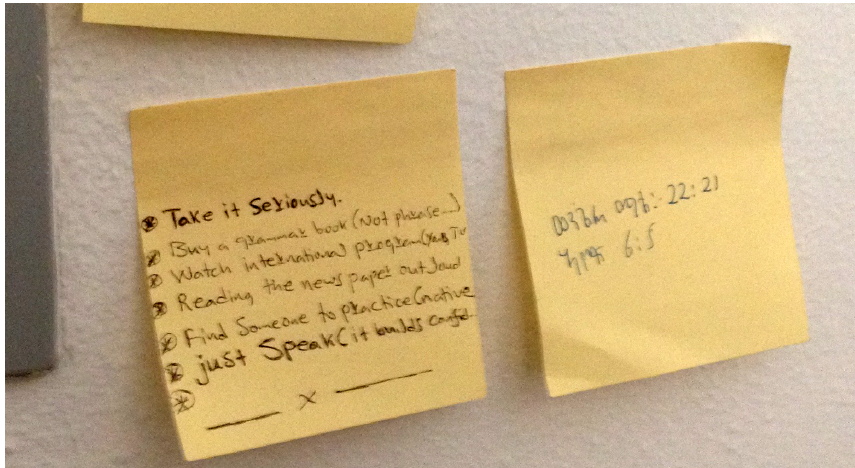
Figure 15. Post-it notes in Yohannes’ room. Some of the text reads: “Which International programs?” “Read the newspaper out loud.” “Find someone to practice Danish (Native)” “Just speak.” April 2017.